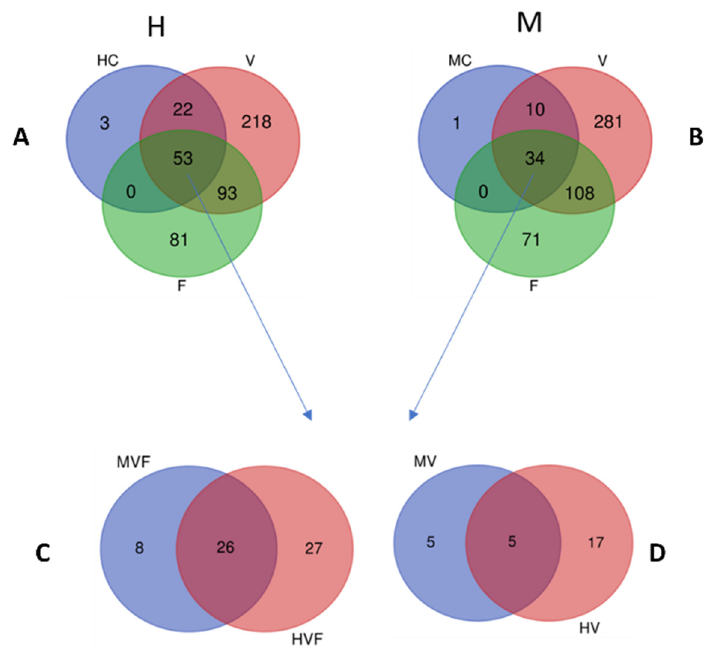
Figure 6. Venn diagrams show OTU distributions between core postpartum uterine microbiomes (OTUs detected in at least one cow per group at all postpartum time points) and the core prepartum vaginal (V) and fecal (F) microbiomes in ( A ) healthy (HC) and ( B ) metritis (MC) cows. Comparison of core healthy (H) and metritis (M) postpartum uterine microbiome bacteria taxa genera that are shared (intersections of HC, V, and F in ( A ) and MC, V and F in ( B )) with ( C ) both core prepartum vaginal and fecal microbiomes, and with ( D ) the core vaginal microbiome only.